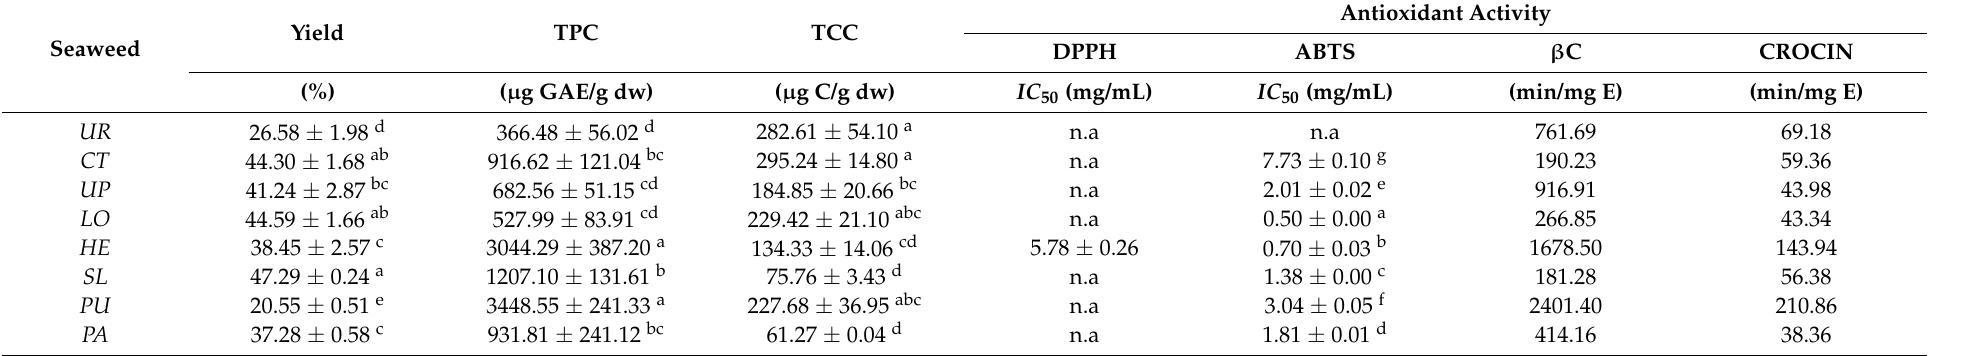
Table 5. Bioactive compound composition and antioxidant activity of the studied